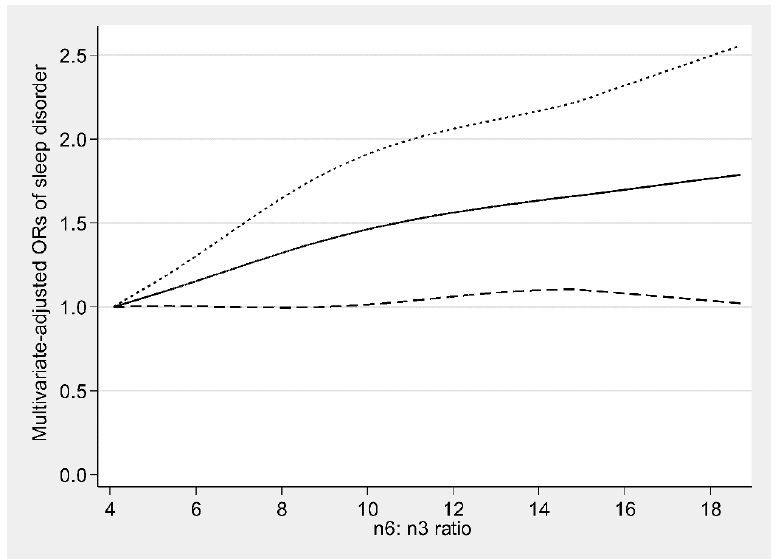
Figure 1. Restricted cubic spline model of the odds ratios (ORs) of sleep disorders with dietary ω-6 fatty acids consumption. The solid line and dashed lines represent the estimated ORs and the 95% confidence intervals.